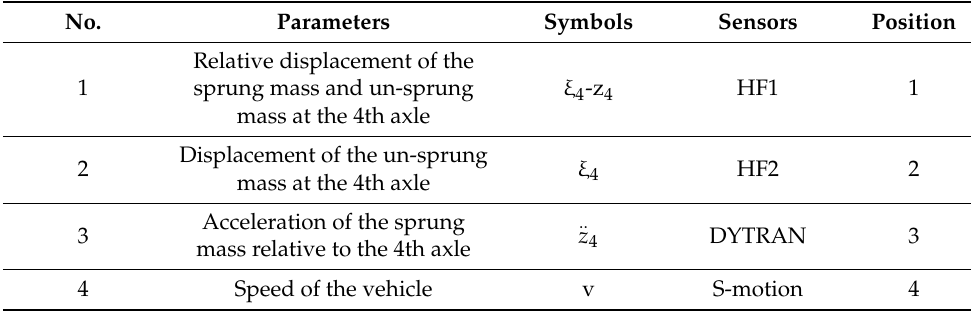
Figure 8. Experiment scenario description. Table 1. Necessary parameters.